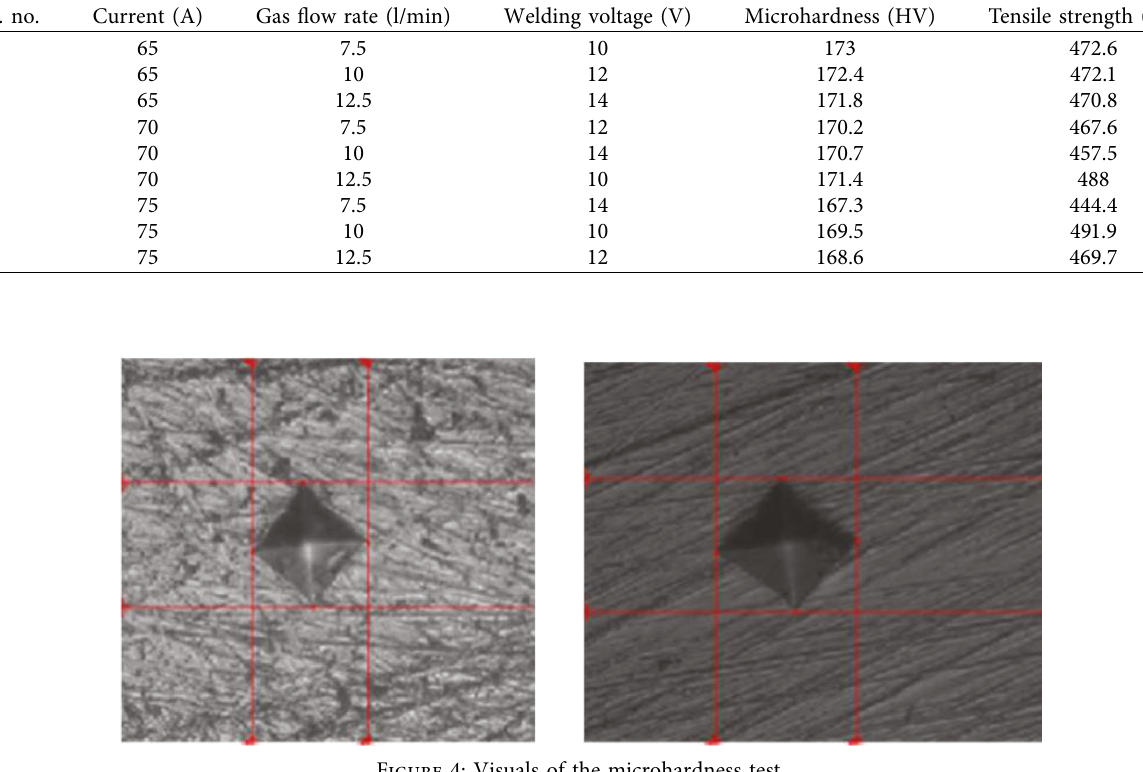
Table 3: L9 orthogonal arrays and their responses.